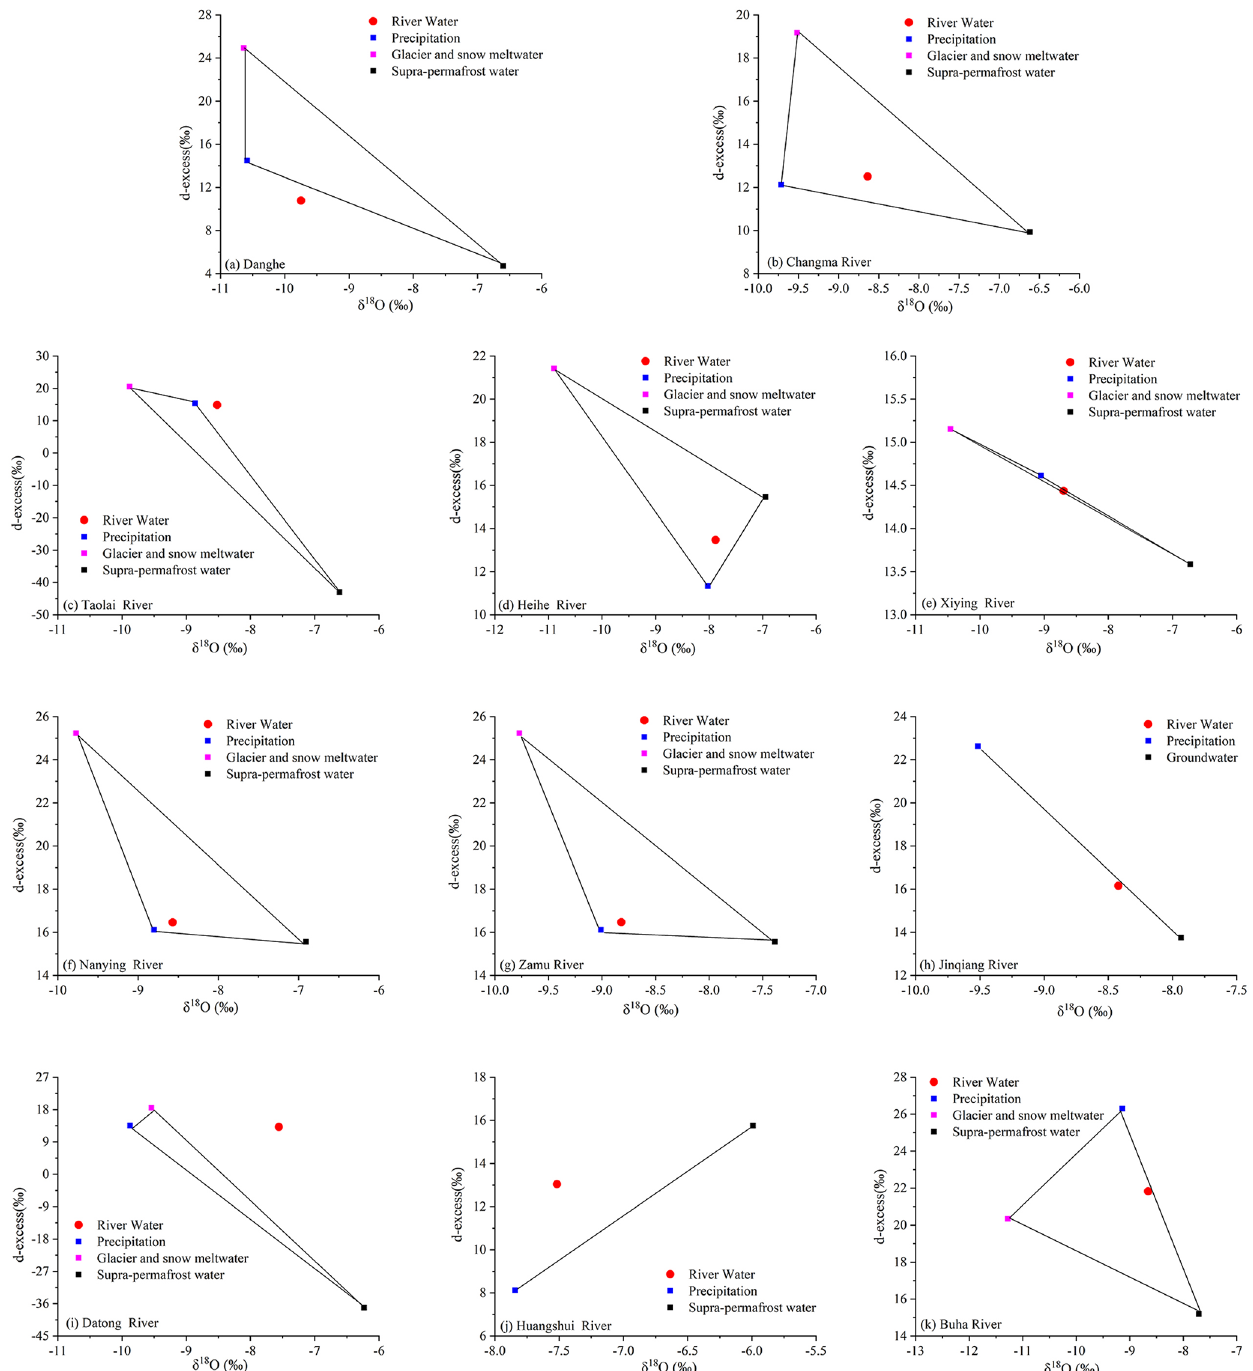
Figure 9. Mixing diagram using the mean values of δ 18 O and d-excess for river water in the Qilian mountains.